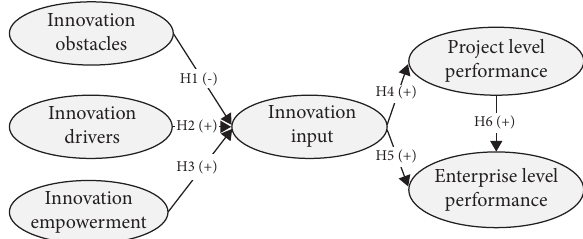
Figure 1: Conceptual model of how innovation influences